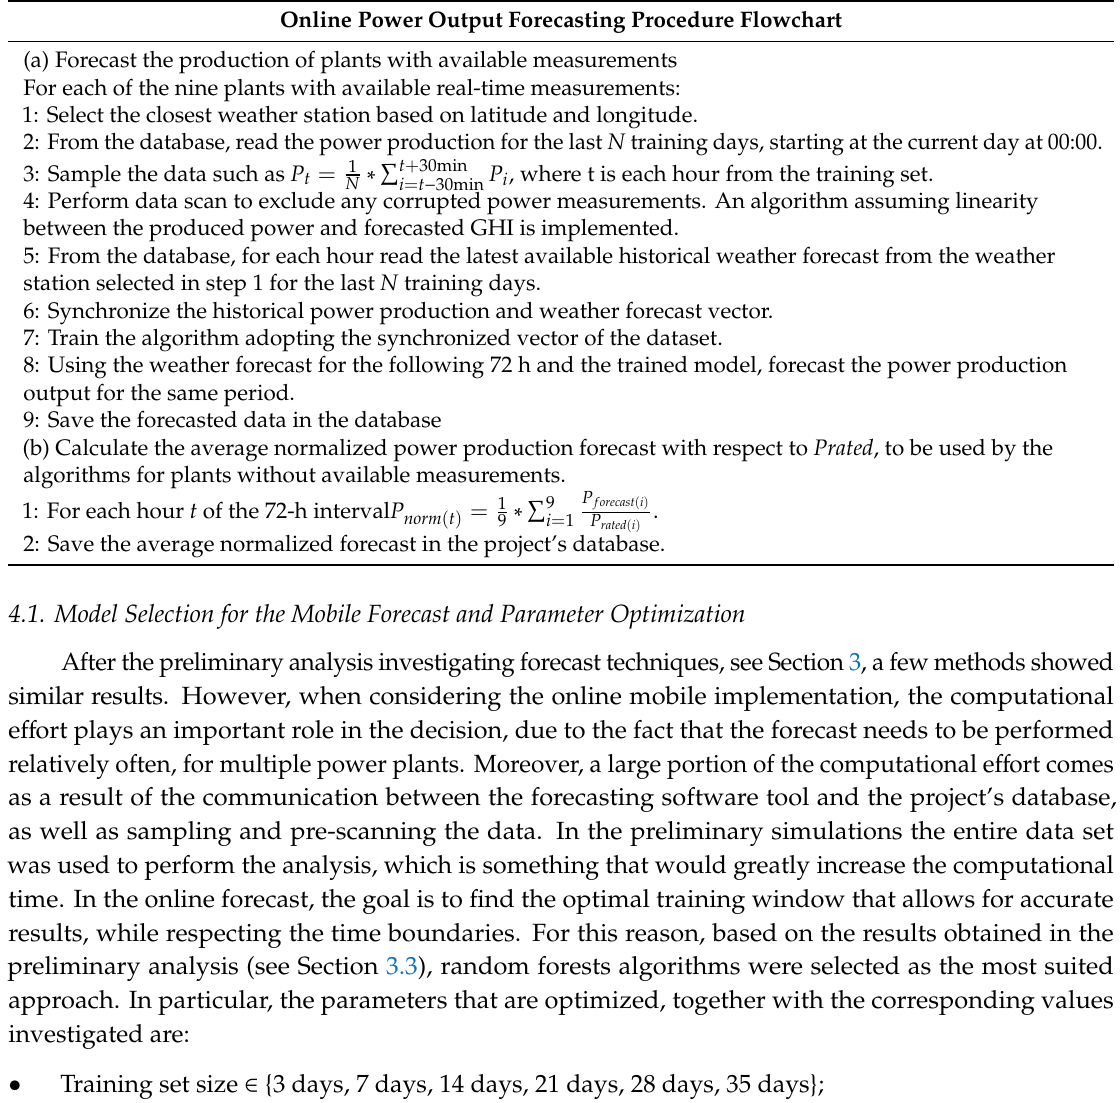
Table 1. Mobile forecasting